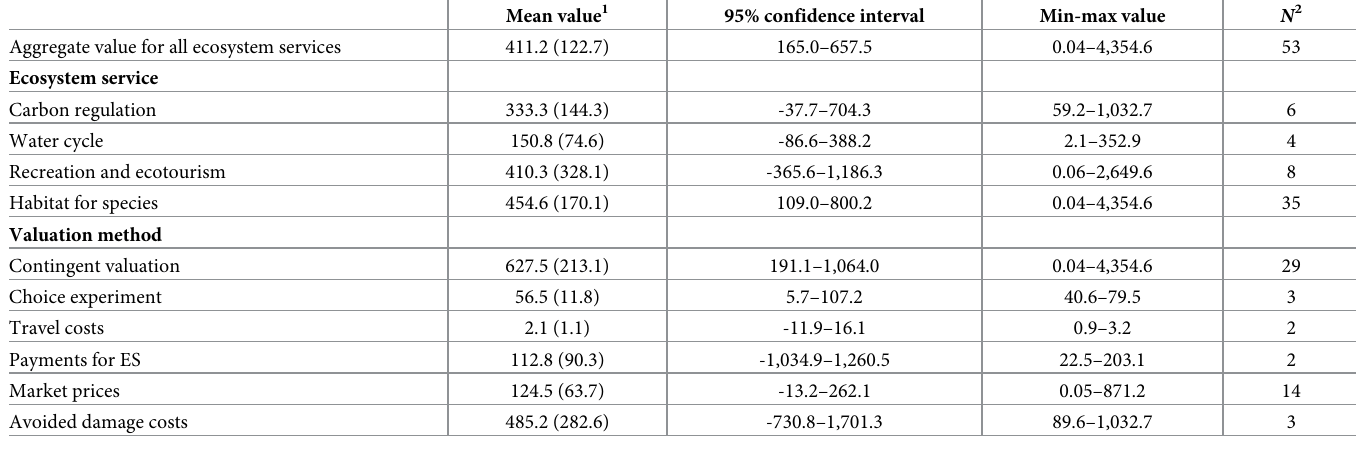
Table 1. Average economic values (2020 USD/ha/year) for the Brazilian Amazon across ecosystem services and valuation